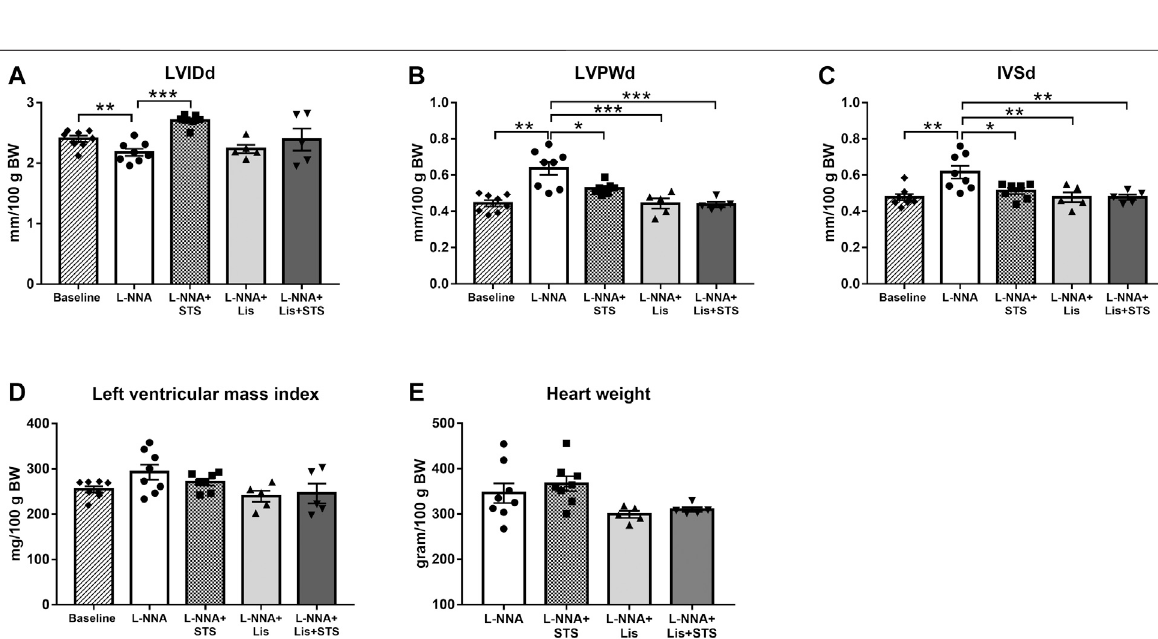
Frontiers in Pharmacology |